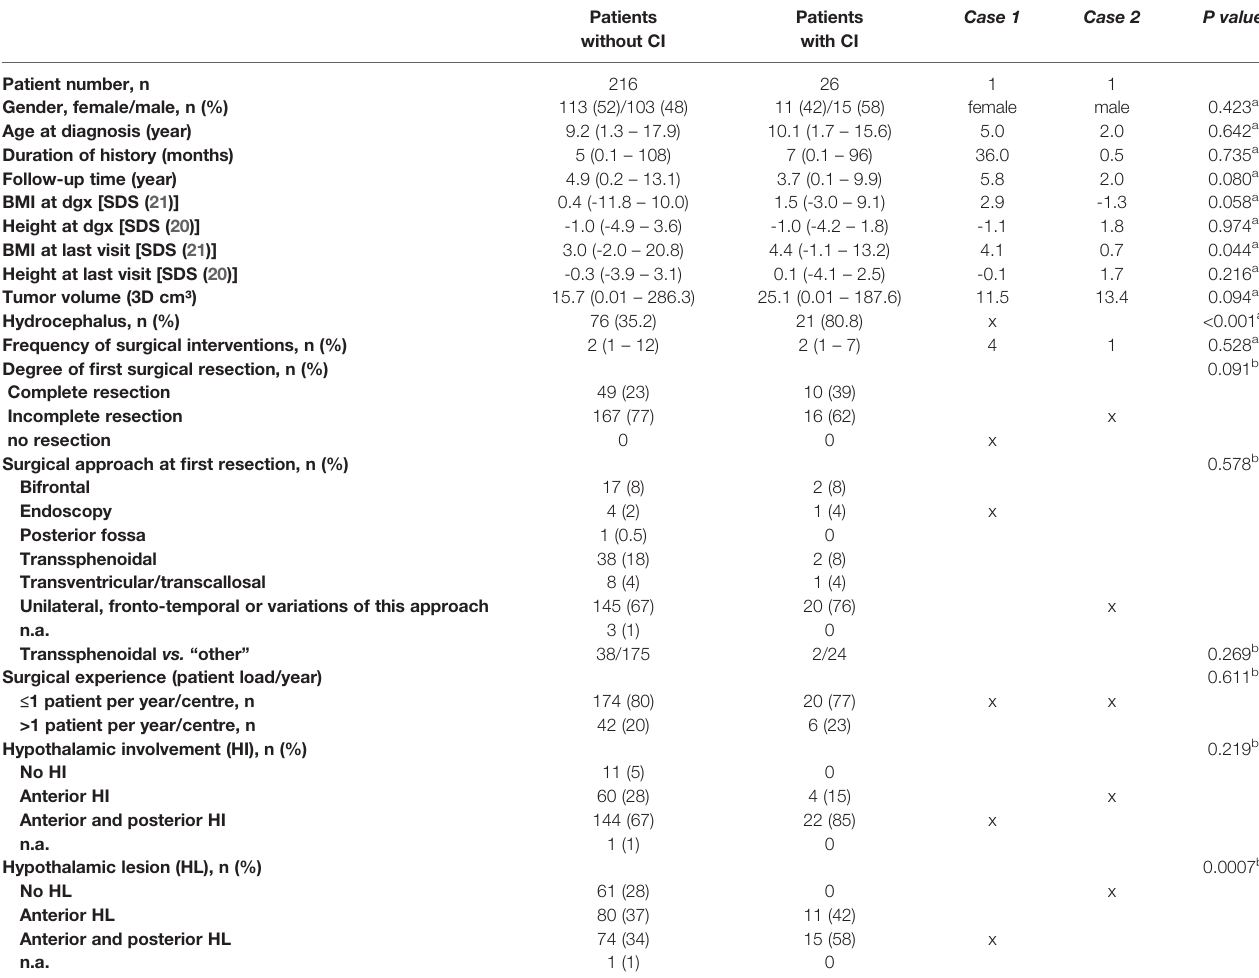
TABLE 1 | Characteristics of the study population showing data for patients with and without cerebral infarction (CI) recruited in KRANIOPHARYNGEOM 2007 between 2007 and